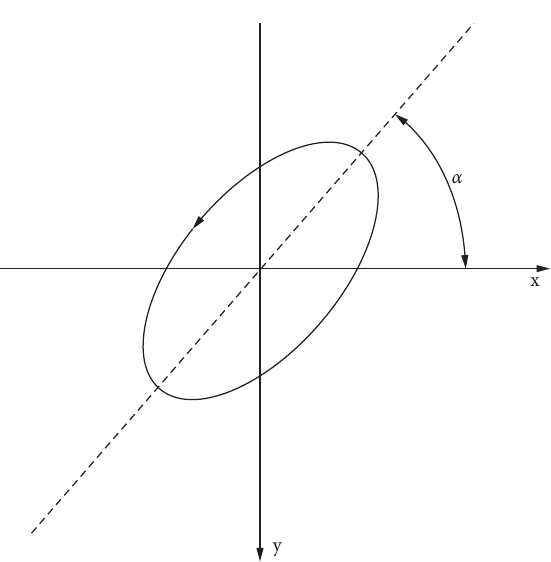
Figure 7: Schematic diagram of circular trajectory.